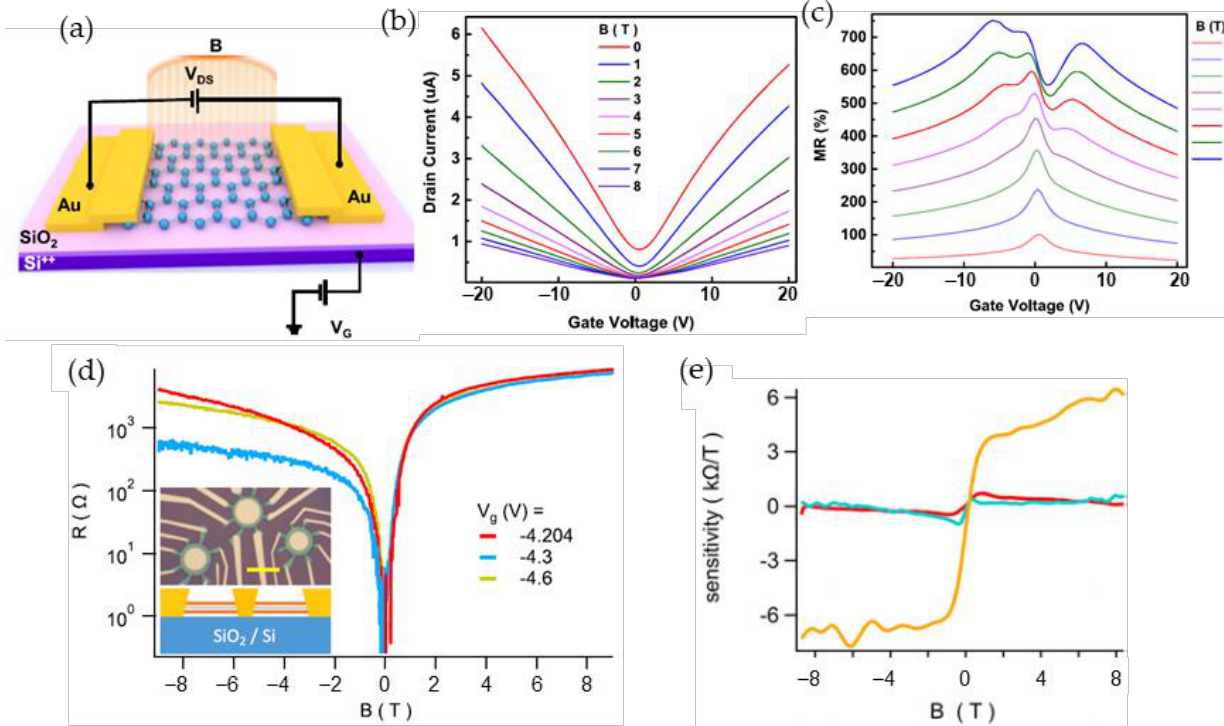
Figure 18. ( a ) A schematic drawing of a gated-sensor based on single-layer graphene in a two-probe configuration. V G is gate voltage, V DS is drain-source voltage, B is normal magnetic field; ( b ) drain current; ( c ) magnetoresistance dependences on V G at different magnetic field values. Reprinted from [138]. Copyright © 2021, American Chemical Society; ( d ) resistance changes of EMR-device with magnetic field at different gate voltages Vg. The inset shows a microscopic image of three EMR-devices fabricated from a single graphene/hBN structure with contacts and central metallic shunt, and the schematic drawing in the side-view geometry; and ( e ) four-terminal sensitivity of devices keeping fixed outer radius of 2.9 µm but changing shunt-to-outer radius ratios: 0.38 (highest, yellow line), 0.63 (blue), 0.75 (red). Reprinted from [139]. Copyright © 2021, AIP Publishing.